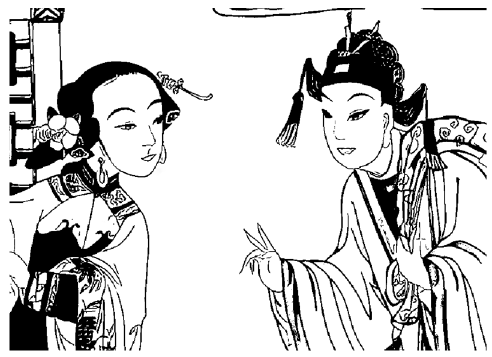
Figure 9. This is a figure. Schemes follow the same formatting.